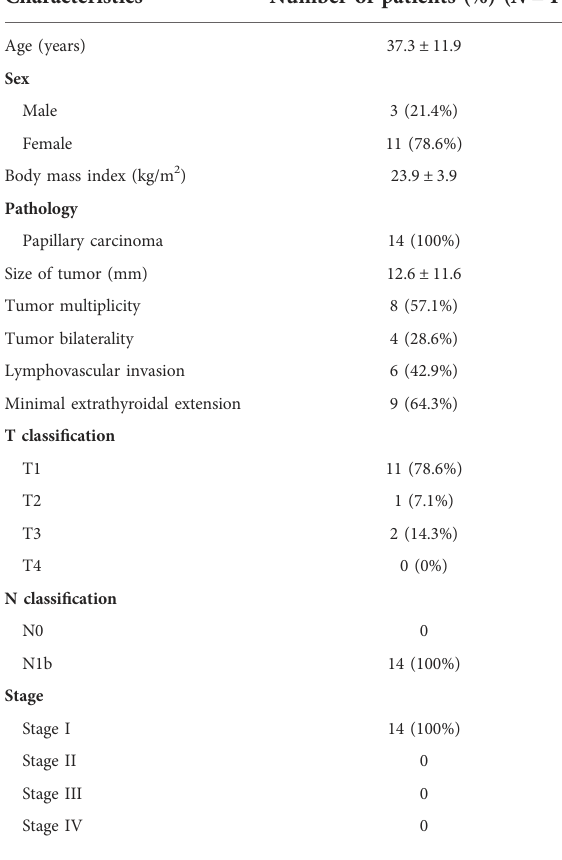
TABLE 1 Clinicopathological characteristics of the patients with papillary thyroid carcinoma.